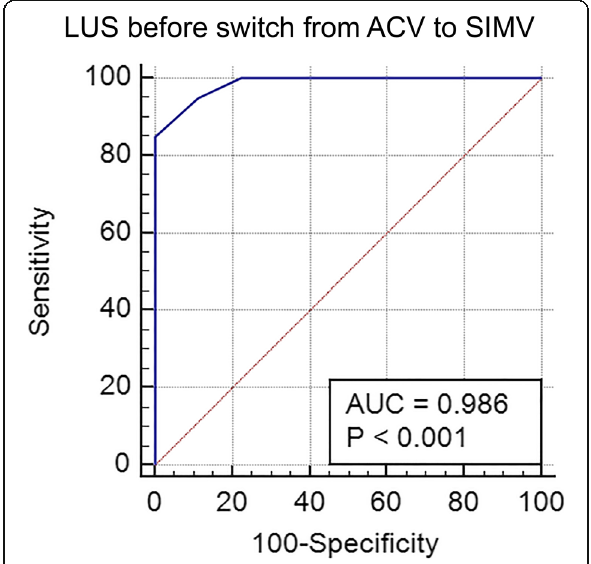
Fig. 4 Receiver operator characteristic (ROC) curve showing sensitivity, specificity, and area under the curve (AUC) for lung ultrasound scores in neonates on AC ventilation before switching to SIMV